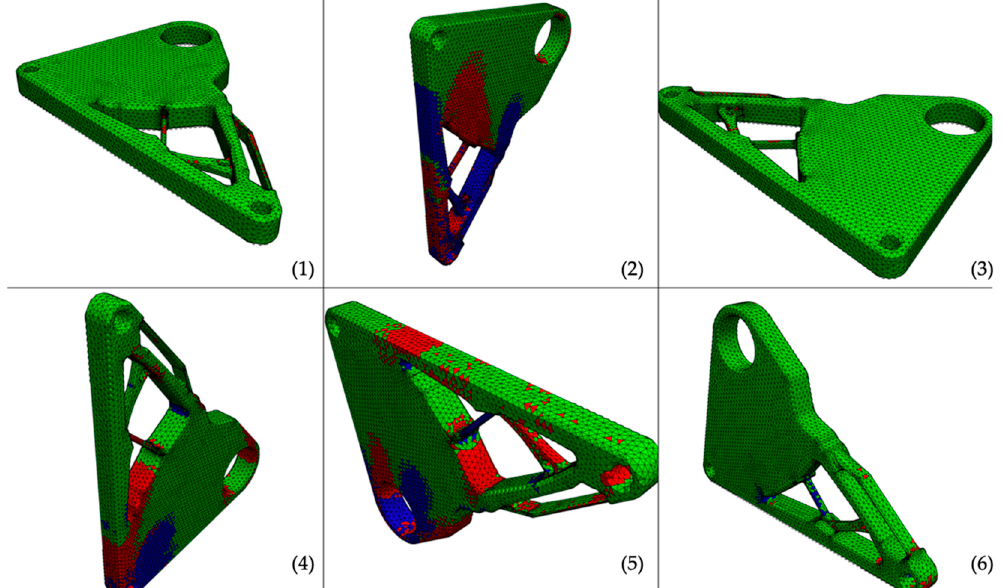
Figure 8. Failure-plot of the debinding simulation of the chassis diverter. ( 1 )–( 6 ) denote the number of the orientation, white dots represent the bottom plane, red areas indicate failure due to tension, and blue areas indicate failure due to compression.